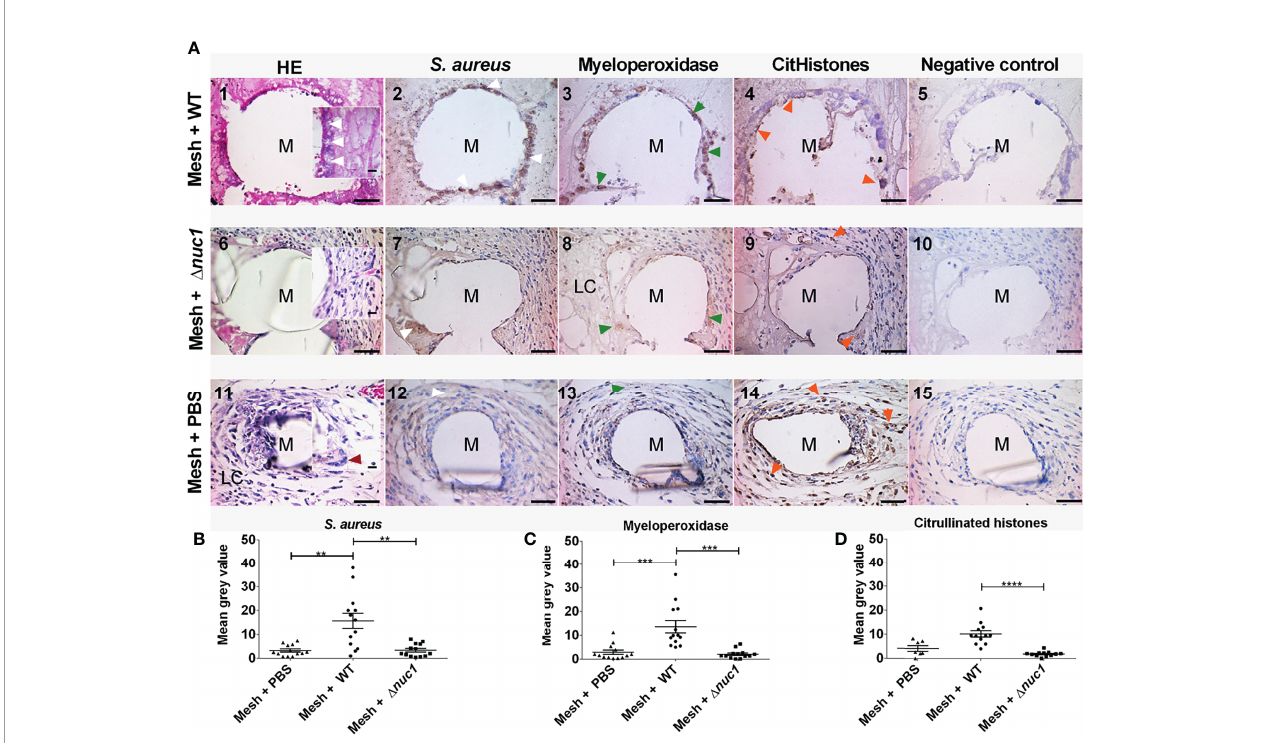
FIGURE 3 | (A) Representative images of hematoxylin (dark blue) and eosin (pink) staining and immune-histochemical detection (brown staining) of S. aureus , myeloperoxidase and citrullinated histones in mice tissue biopsies at positions surrounding a single fi lament of a PVDF surgical mesh implant (M) in combination with an S. aureus Newman WT lux, S. aureus Newman D nuc1 lux or sterile PBS injection, 7 days after implantation. Each image in a row corresponds to the same location in the sample taken from one mouse. White arrowheads show locations of bacterial bio fi lms, dark red arrowheads show locations of foreign body giant cells, green arrowheads show locations of myeloperoxidase and orange arrowheads show locations of citrullinated histones. As a negative control for each antibody staining, primary antibody was replaced with equal amounts of antibody diluent. (B) Semi-quantitative analysis of immunohistochemically determined S. aureus , (C) myeloperoxidase and (D) citrullinated histones. Data points represent data from tissue from 3 different mice and 4 fi laments from each mouse were analyzed except when only one fi lament was present, N=12. Error bars show the standard error of the mean. Statistical signi fi cance between mice with different infection is indicated with asterisks, **P ≤ 0.01, ***P ≤ 0.001, ****P ≤ 0.0001. Scale bar= 50 µm, scale bar insert=25